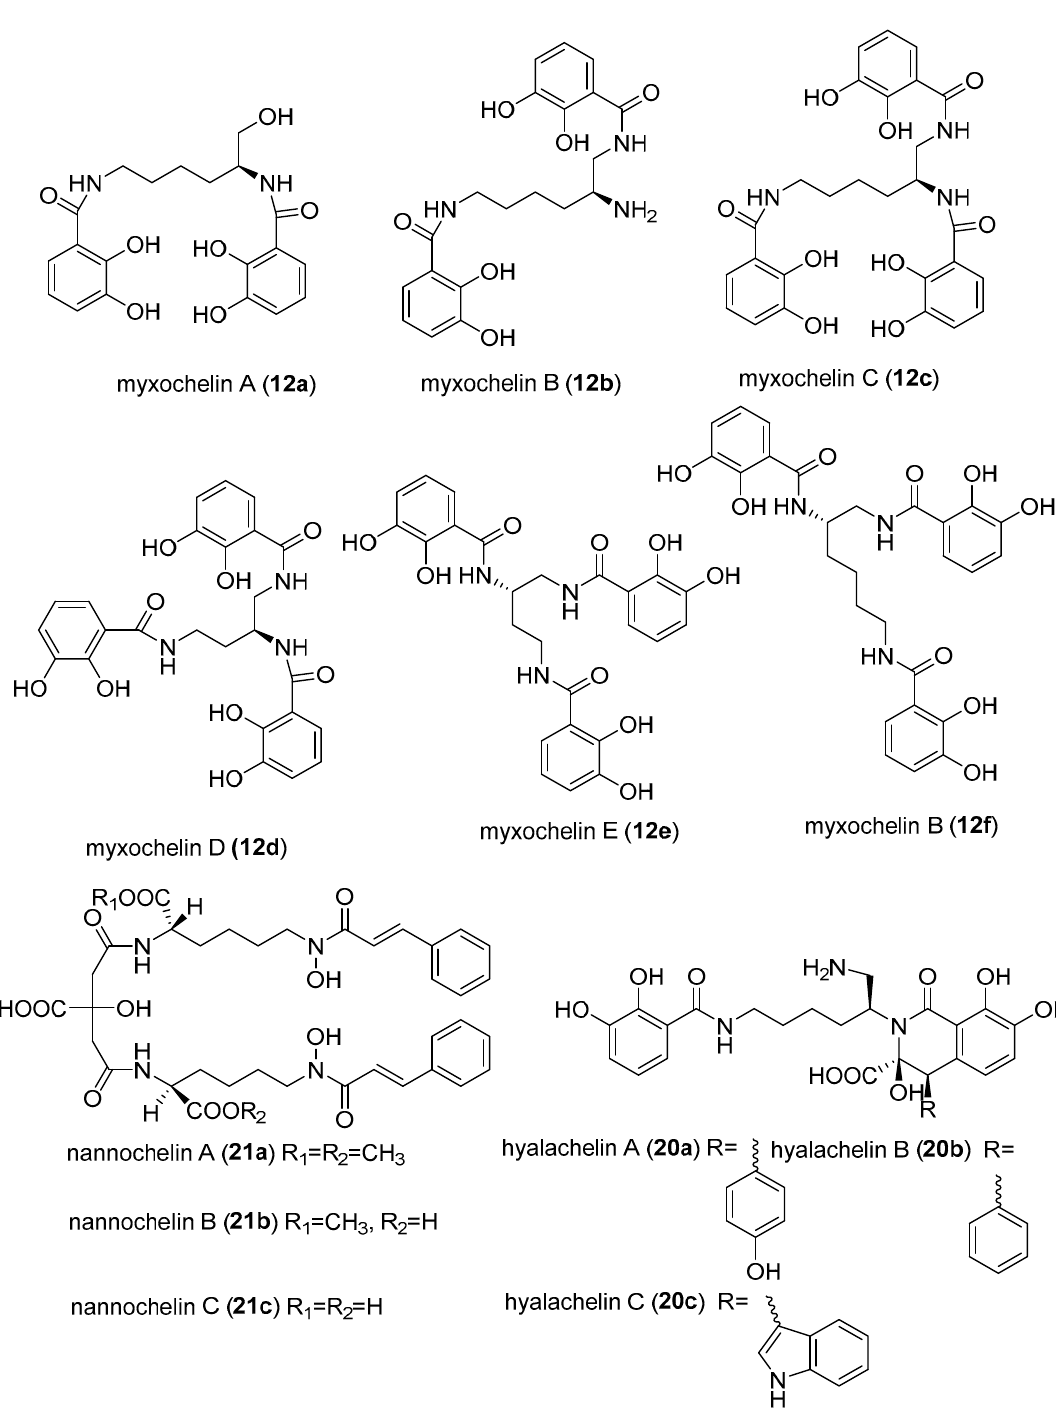
Figure 4. Myxobacterial-derived siderophores.